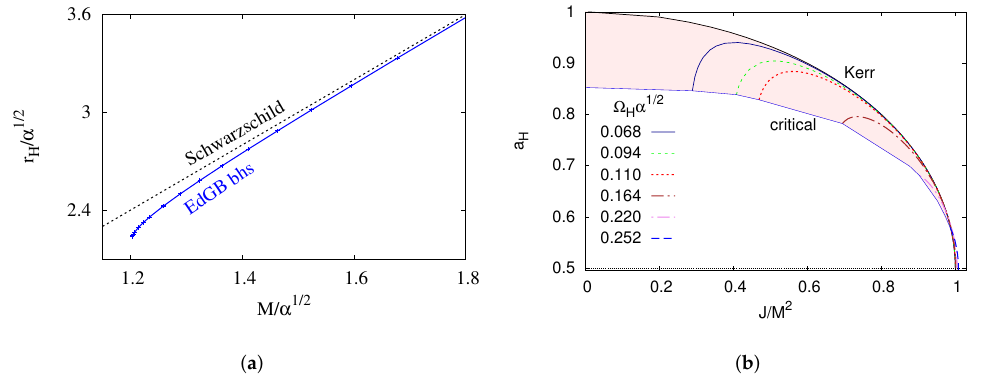
√ √ α vs. scaled mass M / α of